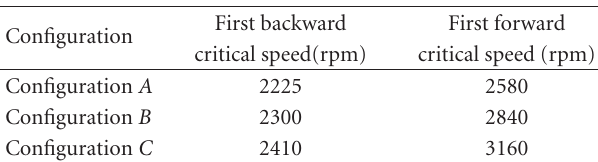
Table 2: Values of the first backward and forward critical speeds of the experimental rotor versus the sti ff ness support.